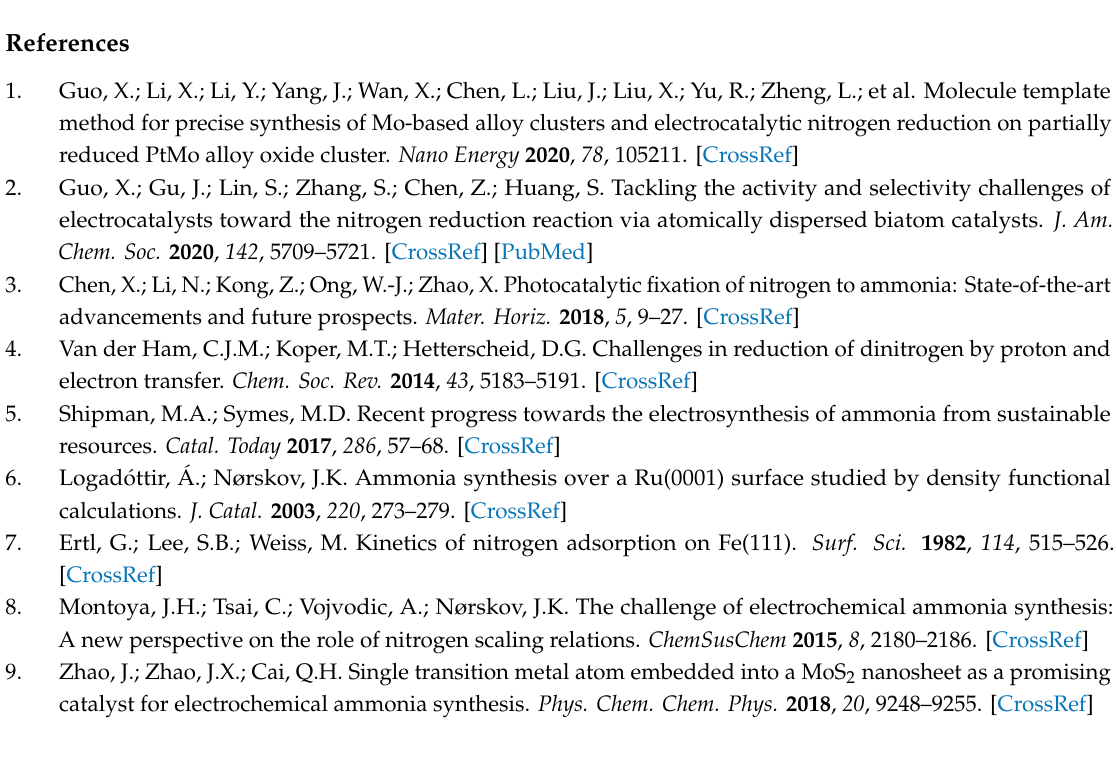
Figure S1: Top and side views of the final structure of Fe 3 @C 2 N through a 10 ps FPMD simulation at 800 K; Figure S2: The magnesium distribution of Fe 3 @C 2 N; Figure S3: Density of states (DOS) of C 2 N and Fe 3 @C 2 N; Figure S4: The energy diagram of N 2 dissociation on Fe 3 @C 2 N; Figure S5: The energy diagram of NRR via